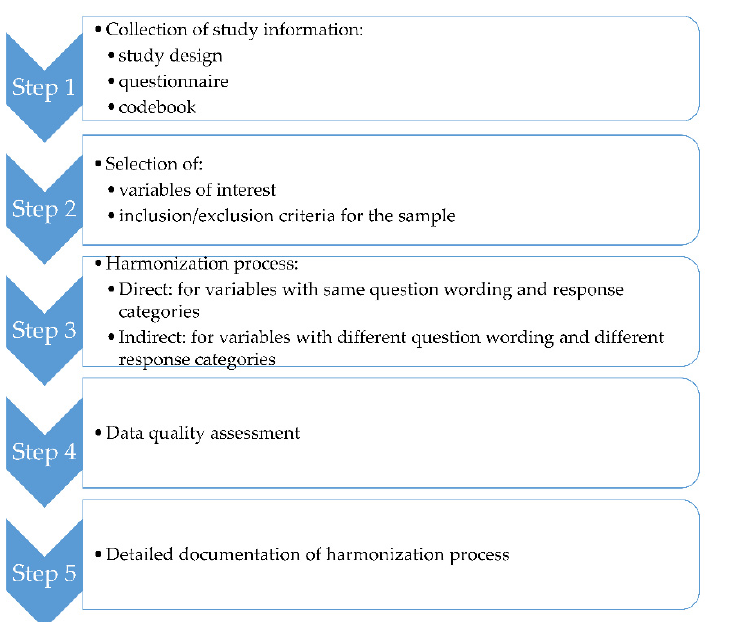
Figure 1. Flow diagram of the sample selection process based on exclusion criteria.